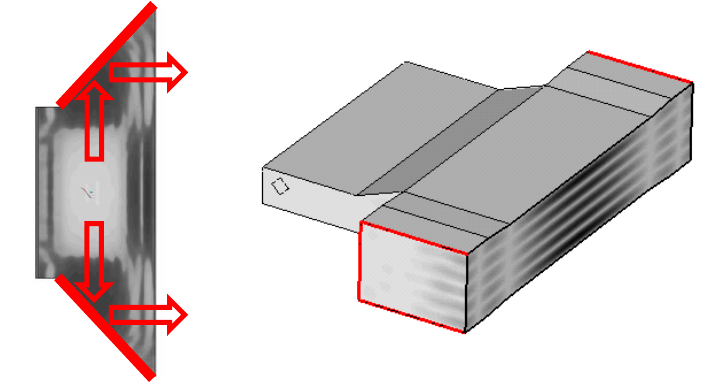
Fig. 1. The cavity and electric field structure of the experimental planar